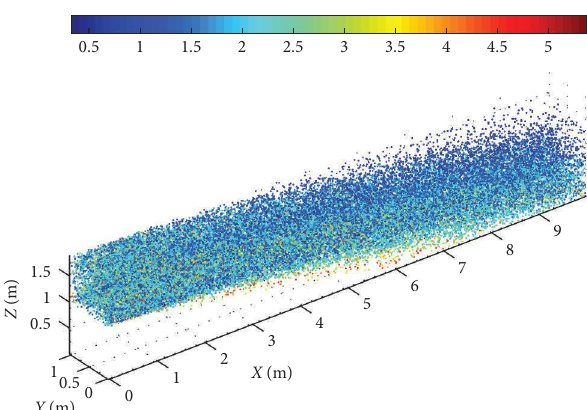
Figure 12: Velocity distribution of particles.